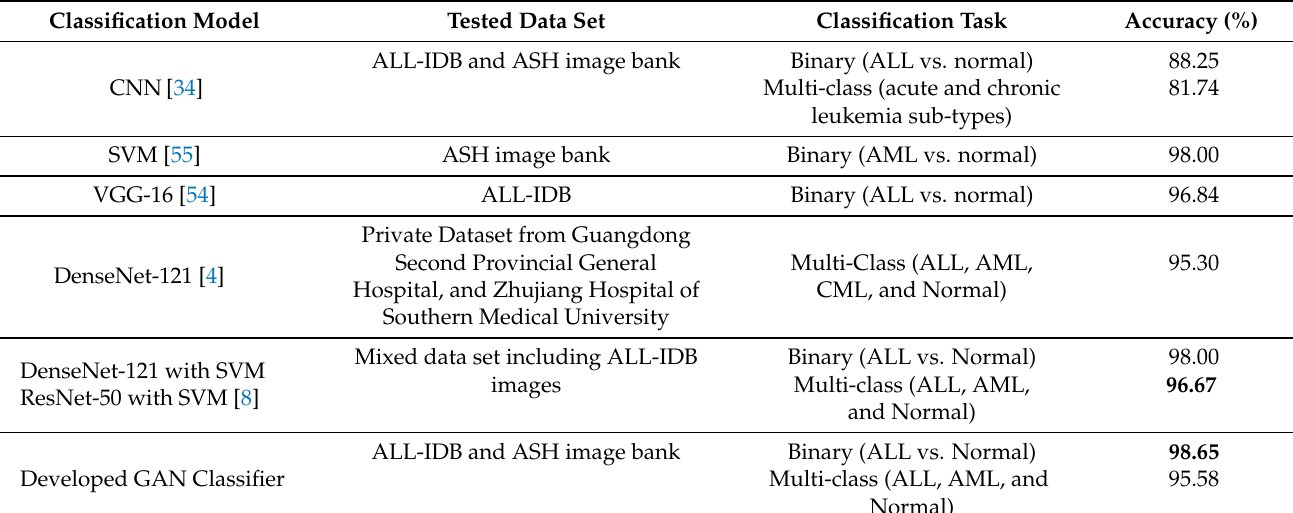
Table 4. Comparison between our developed GAN and other models in previous studies for the classification of